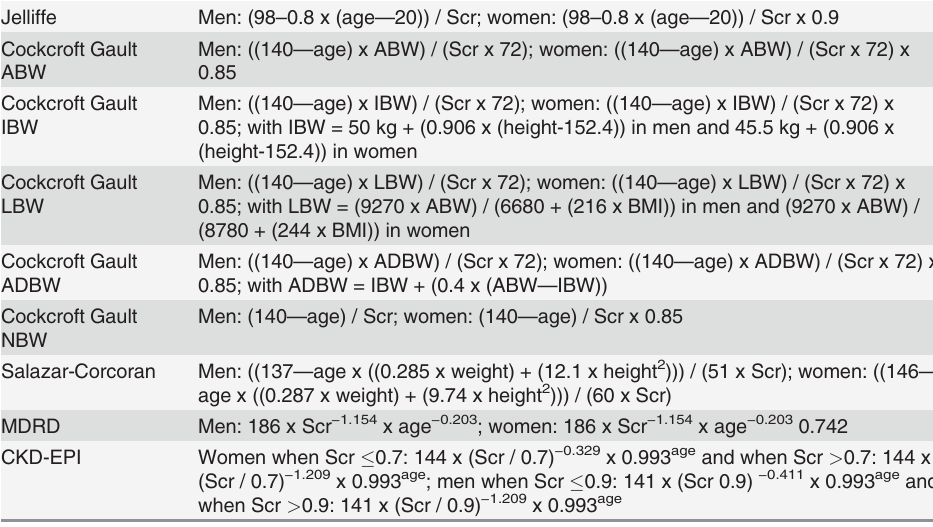
Table 1. Estimated glomerular filtration rate